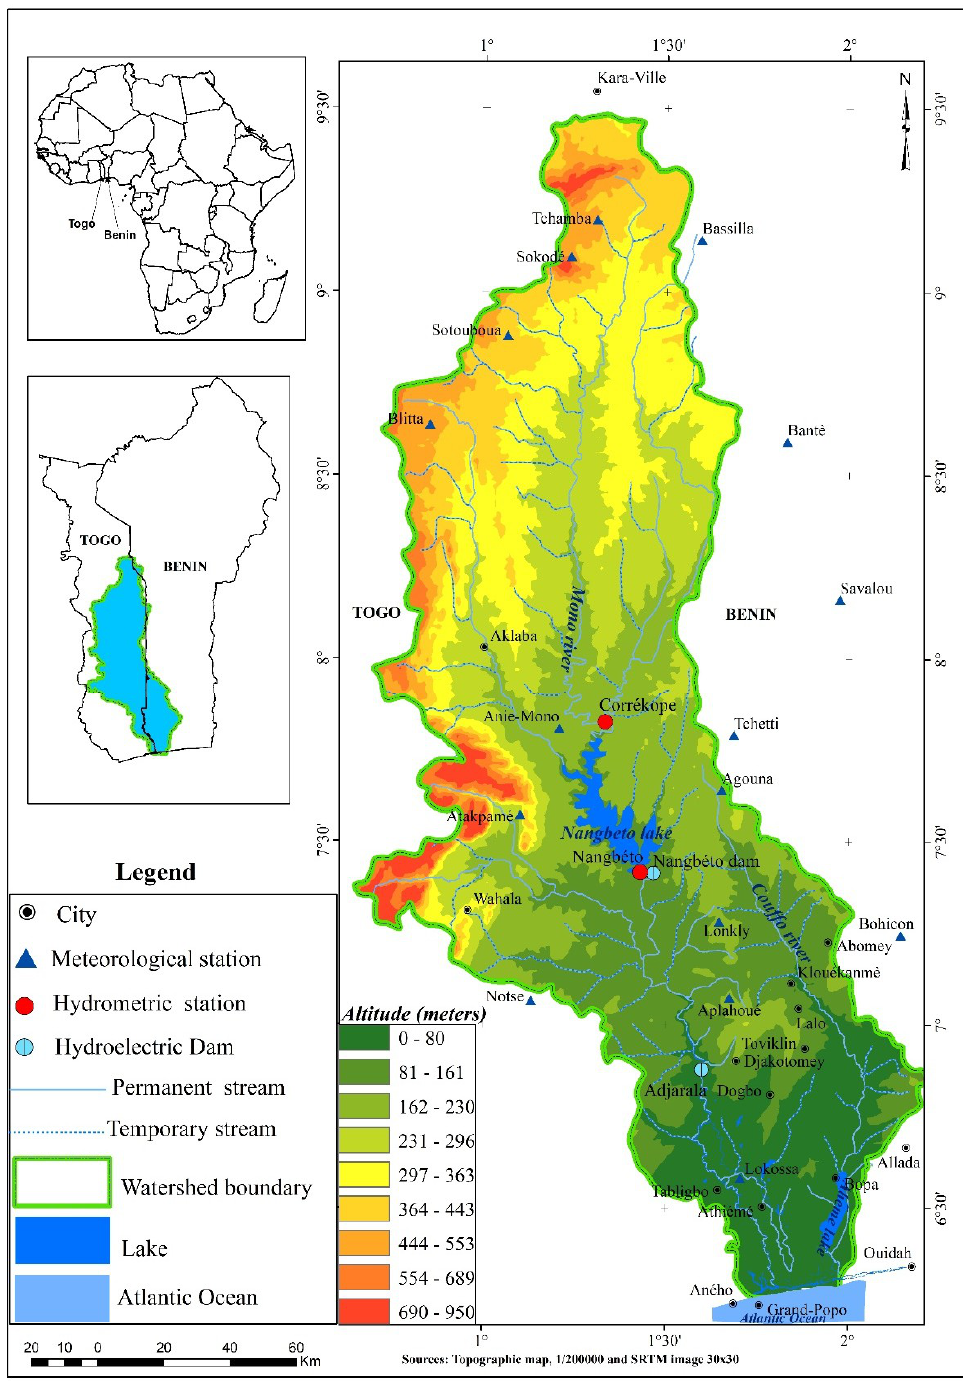
Figure 1. Location of the rainfall (blue triangles) and hydrometric stations (red dots) in the Mono river basin between Benin and Togo.